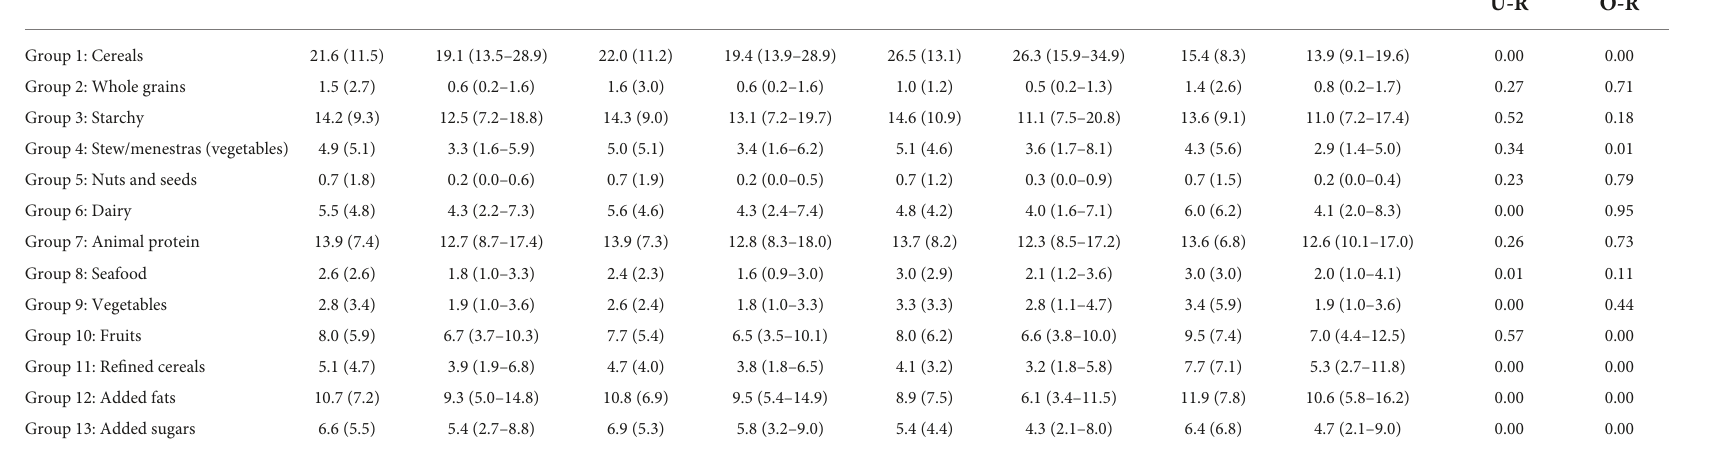
TABLE 3 Food groups contribution to total energy intake by misreporting